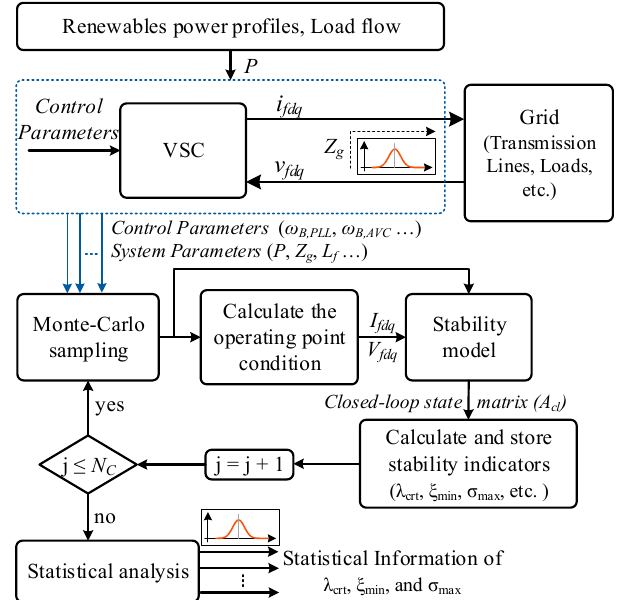
Figure 1. Proposed flow diagram for probabilistic stability and performance assessment of a grid-connected VSC.